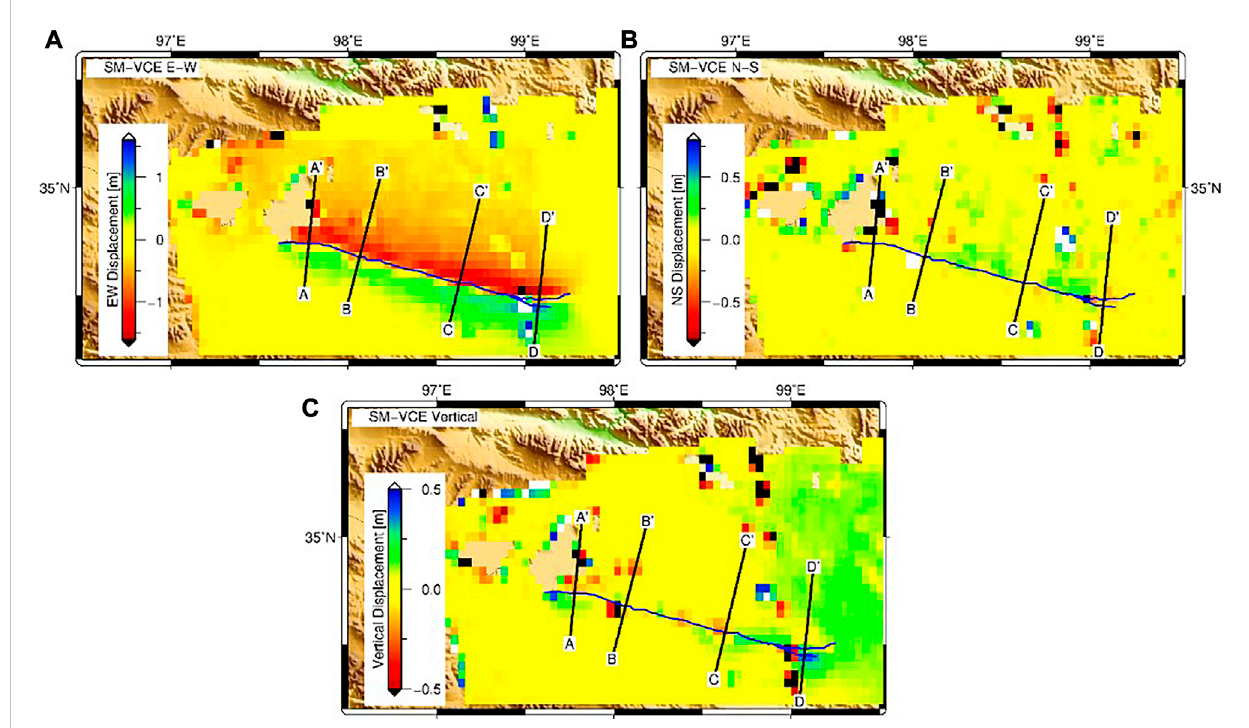
FIGURE 9 SM-VCE resolved 3D deformation of Maduo earthquake when using an equal initial weight of each input grid cell. (A – C) are the east-west, north- south and vertical components.